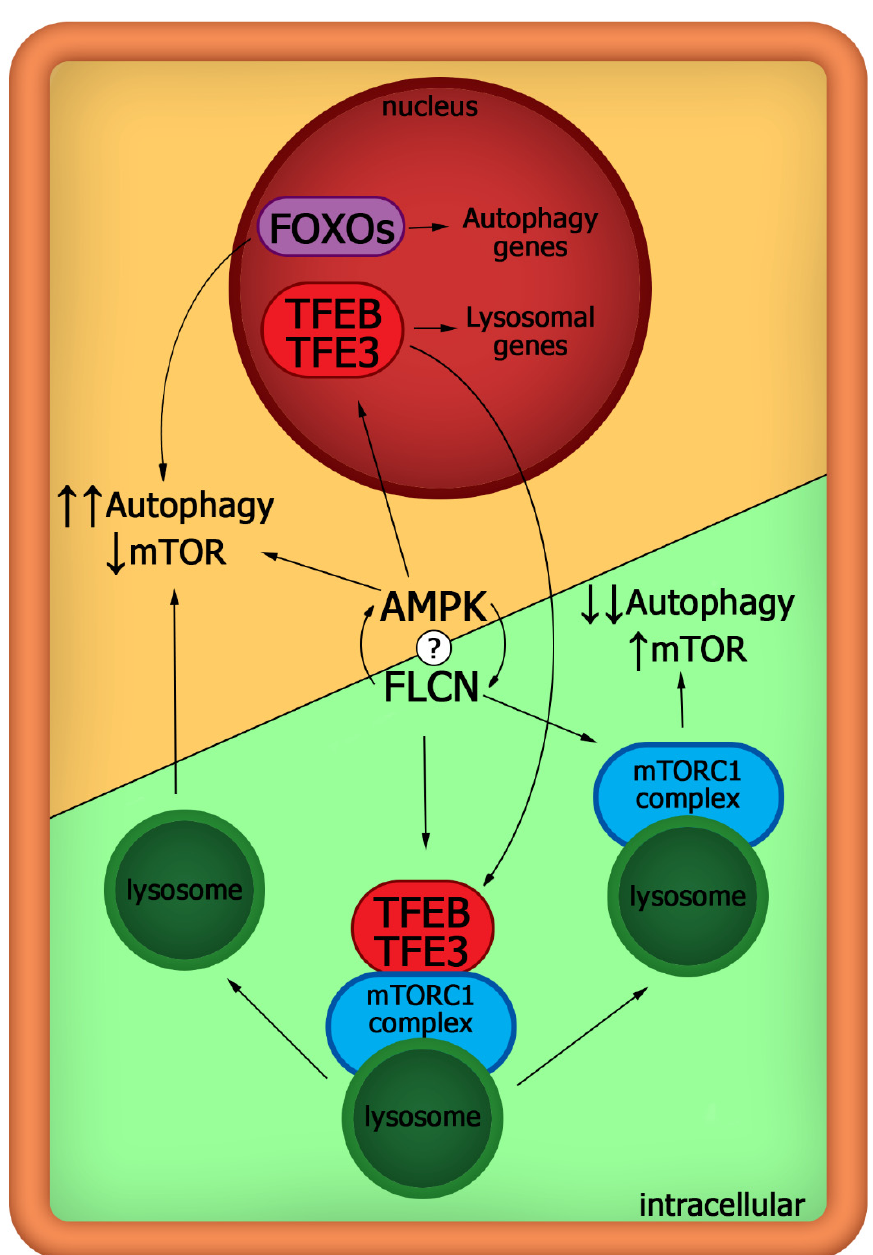
Figure 3. Schematic representation of the key regulation of the mTOR pathway in ESCs during the transition from the naive state to the primed state and vice versa. A high level of autophagy in naive ESCs is maintained by two linked transcriptional modules FOXOs and TFEB/TFE3, which are under the control of AMPK kinase. The mTOR pathway is downregulated and does not interfere with TFEB/TFE3 nuclear localization. Activated FLCN pathway disintegrates AMPK-dependent regulation of autophagy and, as a GTPase activating protein, it recruits mTORC1 and TFEB/TFE3 to lysosomes where mTORC1 inhibits the latter. mTORC1 is activated on lysosomes by Rag and Rheb GTPases and triggers anabolic processes.